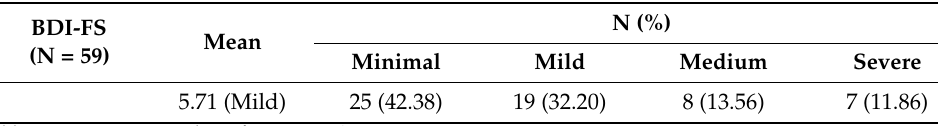
Table 3. BDI-FS scale: sample means and